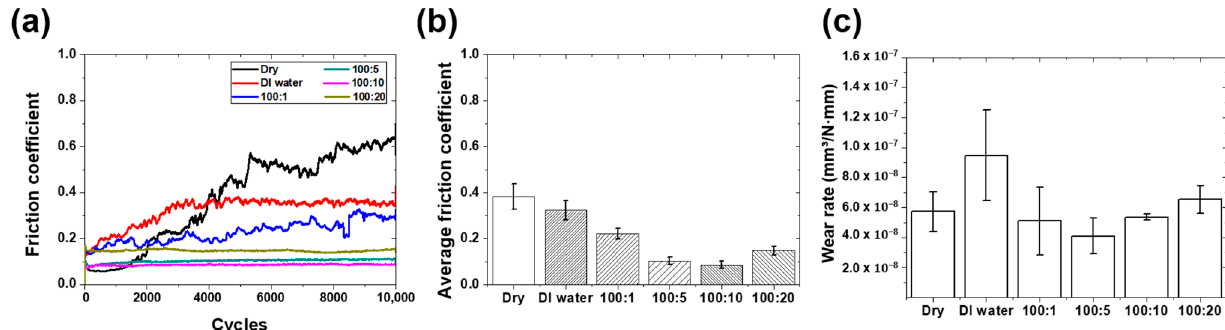
Figure 2. Friction and wear characteristics of graphene-coated stainless steel according to the mixing ratio of DI water: graphene ink ( a ) friction coefficient history, ( b ) average friction coefficient, and ( c ) wear rate.